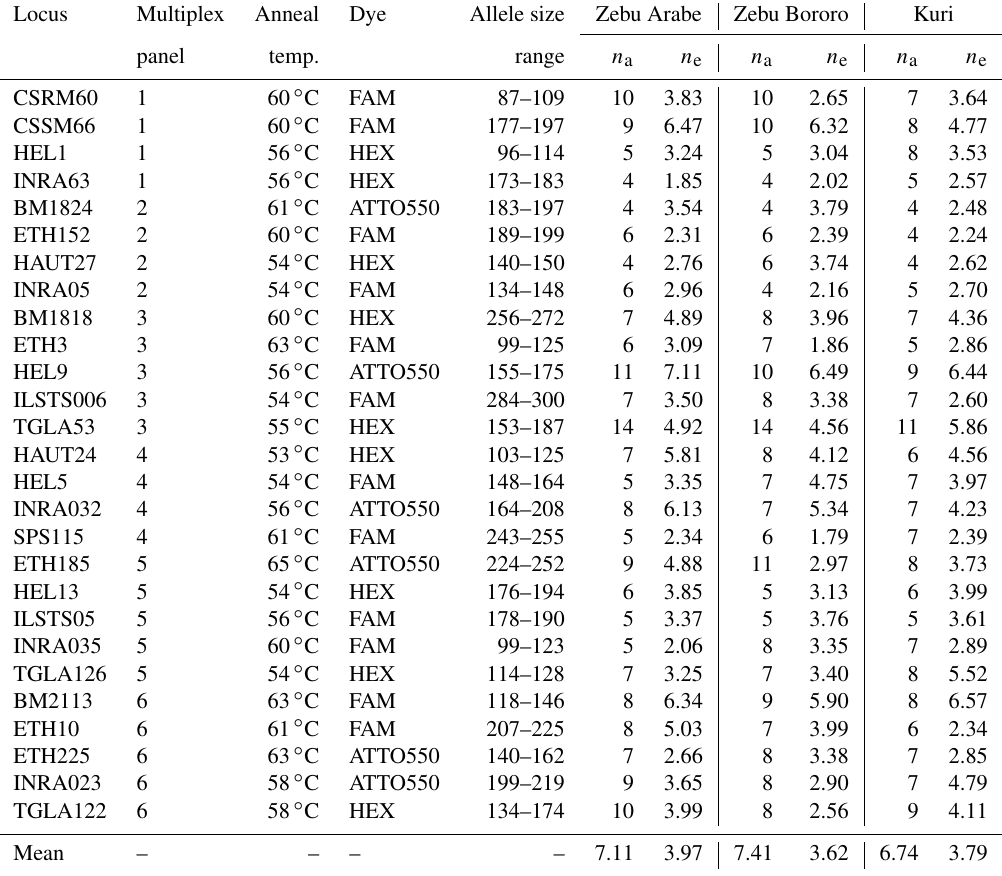
Table 1. Details of microsatellite loci and allelic diversity in Zebu Arabe, Zebu Bororo and Kuri breeds of Niger cattle.